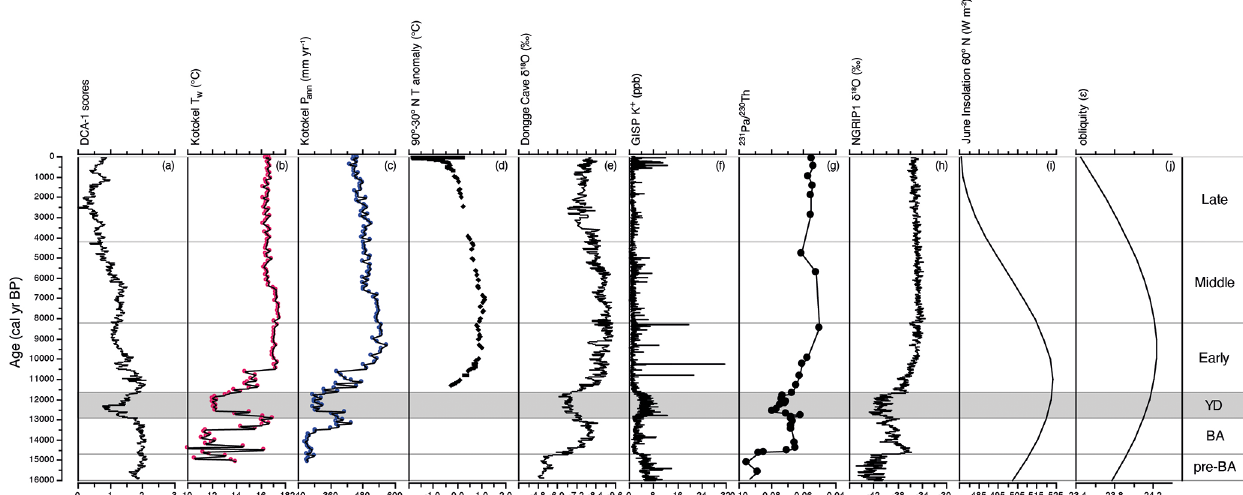
Figure 8. Multi-archive data plotted alongside (a) DCA axis 1 sample scores of Lake Baikal diatoms, as a measure of turnover over the past ca. 16kyr; (b) mean pollen–inferred annual precipitation from Lake Kotokel, with smooth line representing the mean three-point moving average (Tarasov et al., 2009); (c) mean pollen–inferred temperature of the warmest month from Lake Kotokel, with the smooth line representing the mean three-point moving average (Tarasov et al., 2009); (d) mean Northern Hemisphere temperature stack records for 60 ◦ latitude bands (30–90 ◦ N; Marcott et al., 2013); (e) δ 18 O values of Dongge Cave stalagmite D4 (Dykoski et al., 2005); (f) K + ion concentrations (ppb) from GISP2 D core (Mayewski et al., 1997); (g) North Atlantic core GGC5 231 Pa / 230 Th meridional circulation data; (h) δ 18 O values of NGRIP ice core (Rasmussen et al., 2006); (i) June insolation 60 ◦ N (Wm − 2 ; Berger and Loutre, 1991); (j) obliquity ( ε